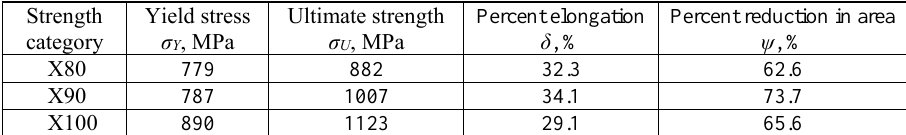
Table 2. Average strength and deformation properties of steels X80, X90 and X100 during tensile tests in the temperature range from +20 ° C to – 100 °